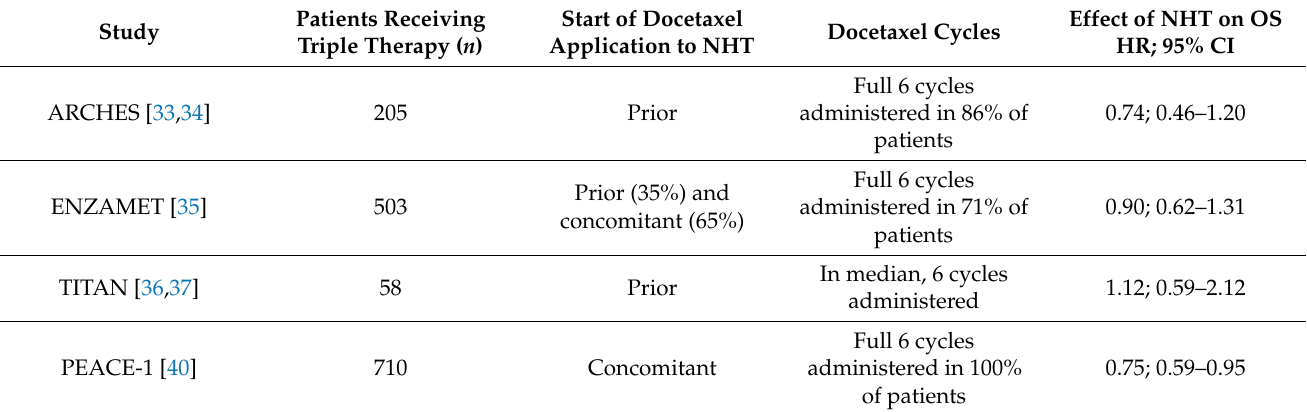
Table 2. Available subgroup data for triple therapy with ADT + docetaxel as standard of care in